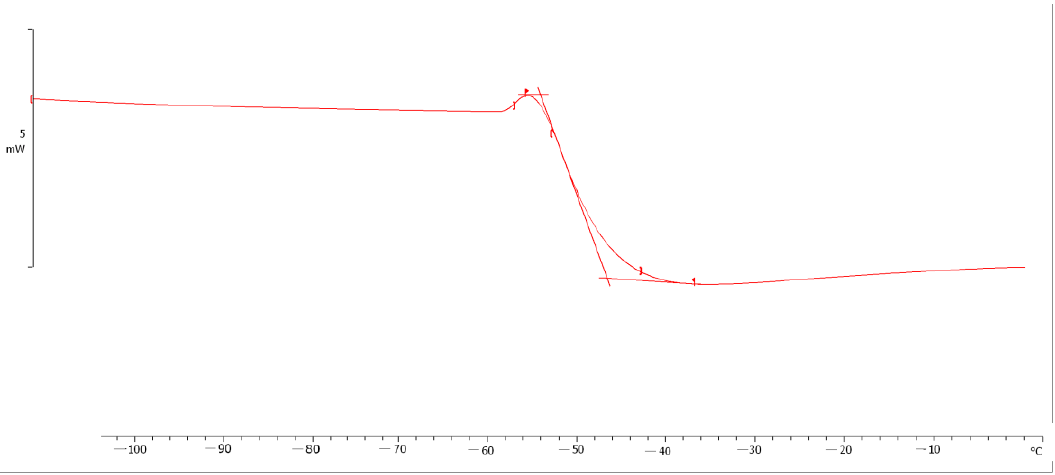
Figure 2. DSC thermogram of PVC composition with DBEA. Table 2. Glass transition temperatures of PVC compositions containing alkyl butoxyethyl adipates.